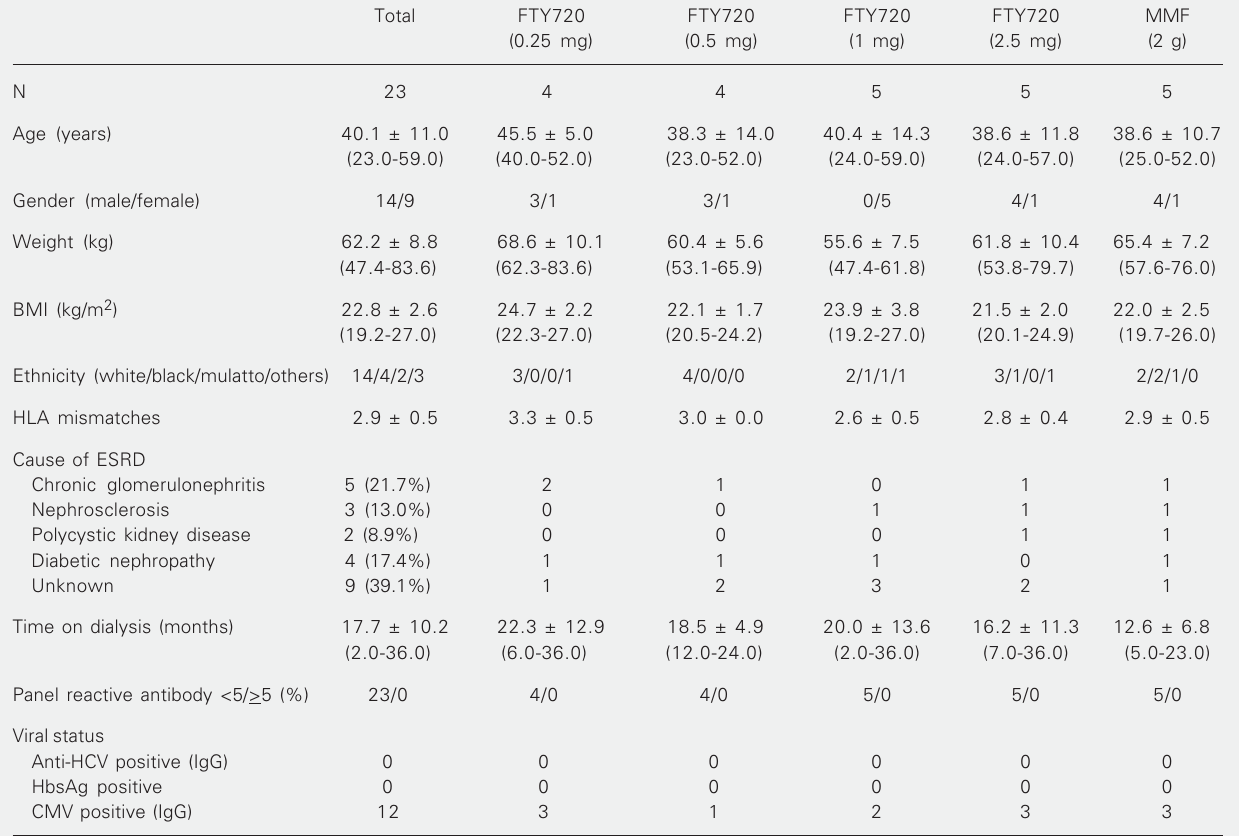
Table 1. Demographic characteristics of the transplant population.